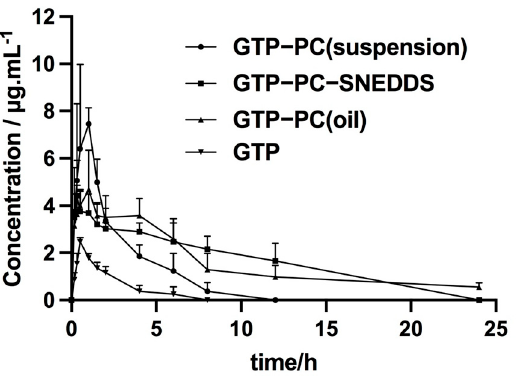
Figure 7. Mean plasma concentration–time curve of GTP, GTP‑PC (suspension), GTP‑PC (oil) solu‑ tion, and GTP‑PC‑SNEDDS after single po dose of 80 mg/kg GTP in SD rats, n = 6. Table 11. Pharmacokinetic parameters and bioavailability of GTP, GTP‑PC (suspension), and GTP‑ PC (oil solution) to SD rats (n = 6).